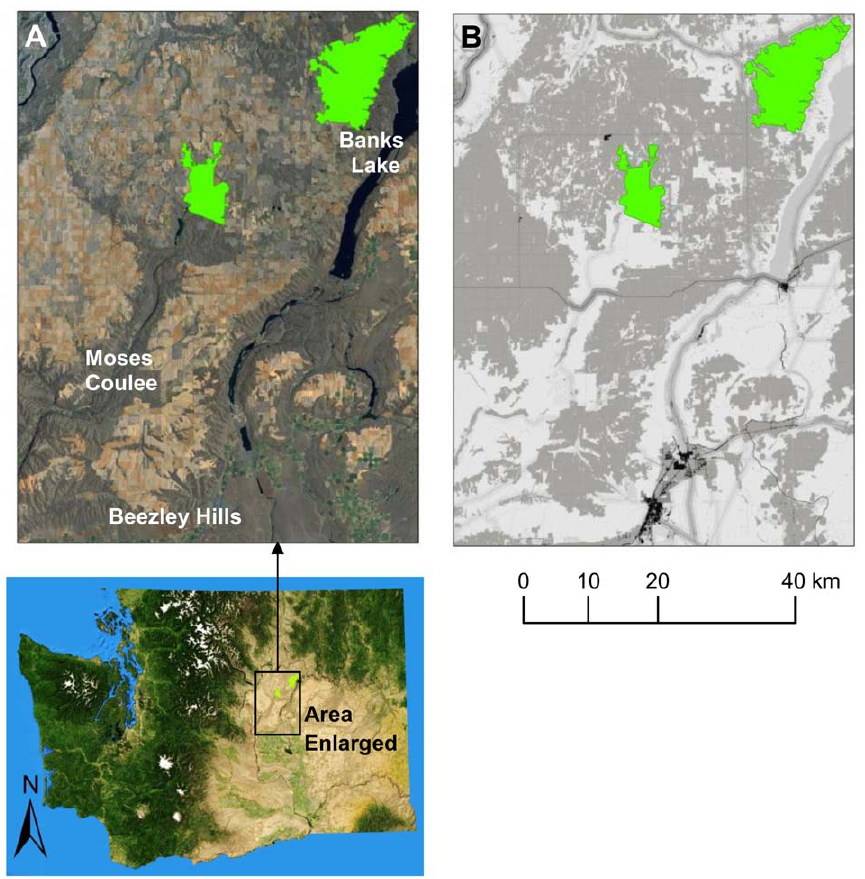
Figure 5. Corridor analysis in a landscape undergoing active conservation planning. (A) 60 km by 80 km study area in eastern Washington, USA, containing two natural landscape blocks to be connected (green). (B) Resistance map used to model corridors in a recent multi- partner connectivity analysis across the Columbia Plateau Ecoregion [41]; values range from 1 (white) to 1000 (black). Low resistance areas include native grassland and shrub-steppe, whereas high resistance areas include roads, developed areas, and agriculture.